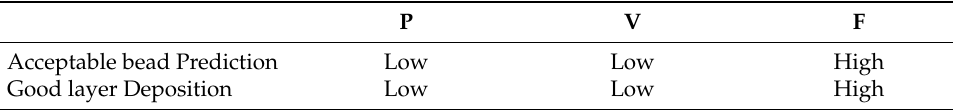
MAPE is the representation of MAE as a percentage. 335